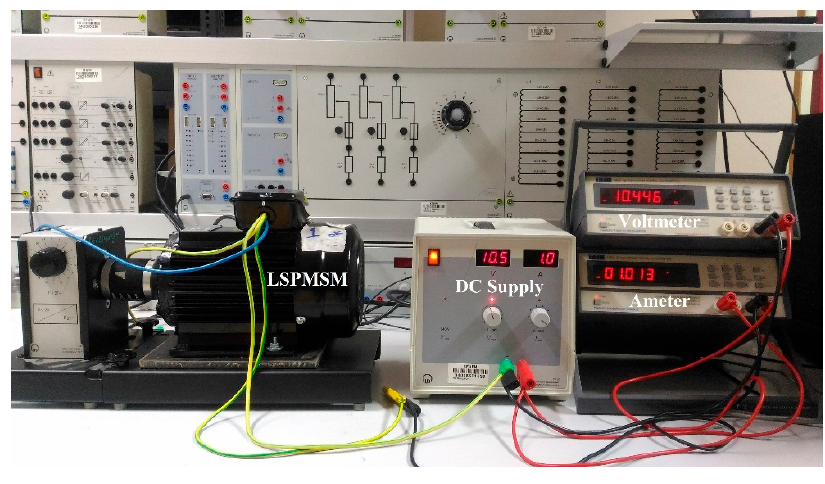
Figure 2. DC test setup.